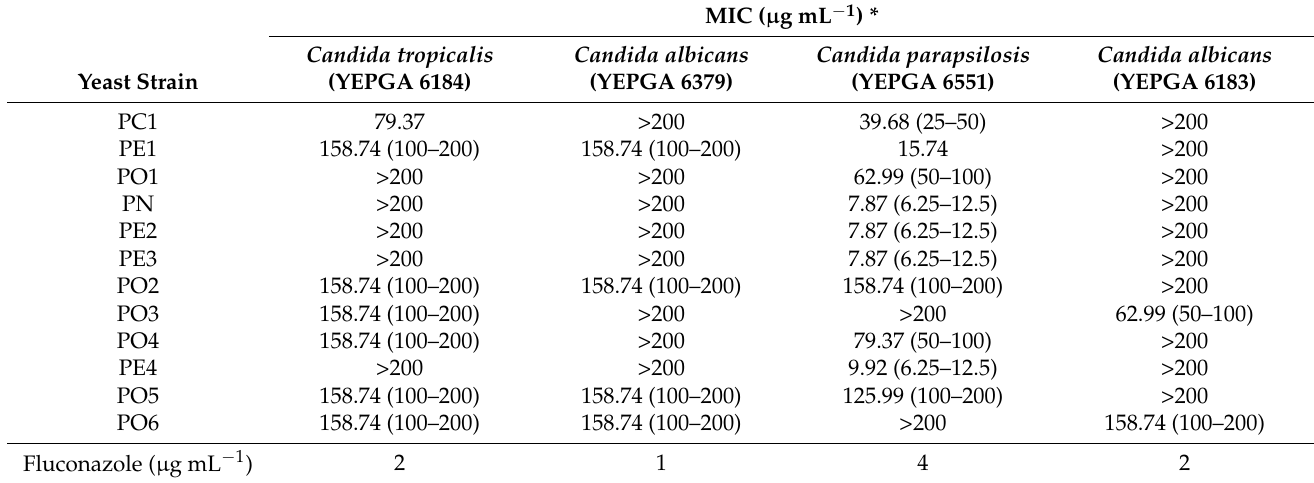
Table 9. Minimal inhibitory concentrations of Pleurotus mycelia (S2) extracts against yeast isolates.